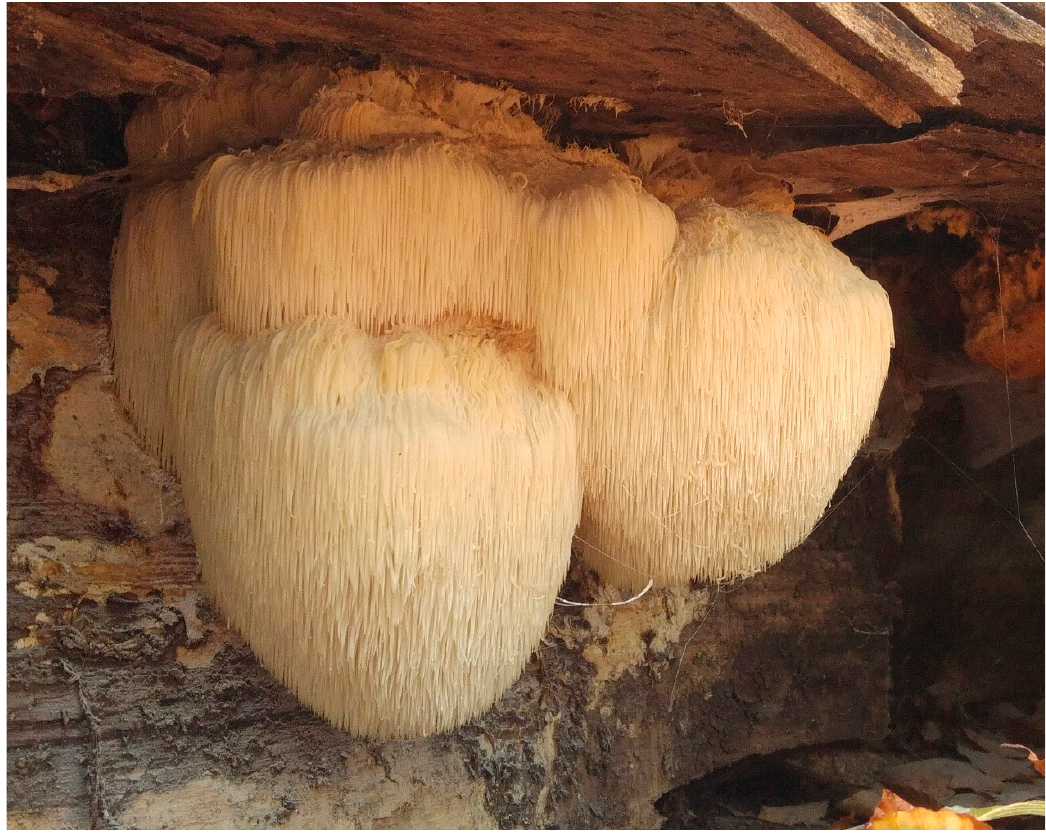
Figure 1. Hericium erinaceus in its natural habitat (photo by Pawe ł Stasiowski). Table 2. Chemical structures of bioactive compounds found in edible mushrooms.